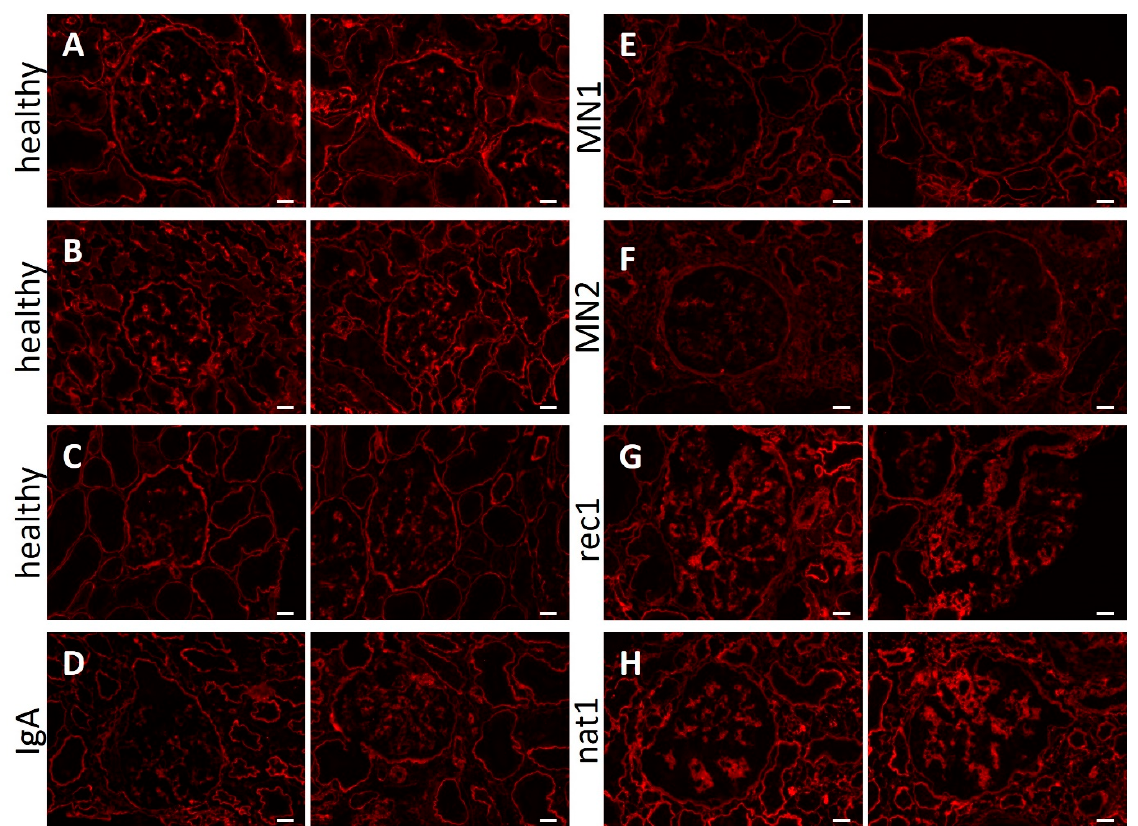
Figure 8. Increased glomerular perilipin-2 expression in patients with FSGS. Fluorescence microscopy images of kidney cortex sections stained for perilipin-2. Two representative images are presented of healthy subjects ( A – C ), disease control biopsies from patients with IgA nephropathy ( D ) and membranous nephropathy ( E , F ), or biopsies from patients rec1 ( G ) and nat1 ( H ) with primary FSGS, presumed to contain CPF(s). Scale bar: 50 µm.